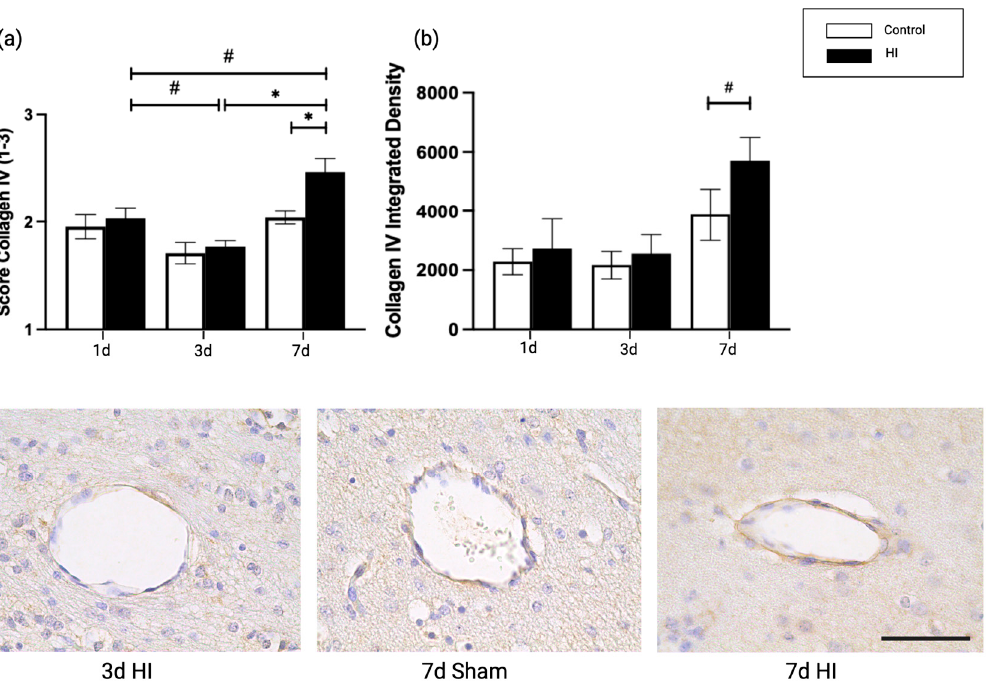
Figure 3. Collagen type IV ( a ) qualitative scoring; ( b ) integrated density measurement on 1, 3 and 7 days after HI; ( c ) representative images of consecutive brain sections of cerebral blood vessels stained with collagen type IV. An average of 40 fields of view per animal were analyzed. Graphs show the average integrated density (mean grey value of stained area × percentage of stained area) of collagen type IV expression in coronal brain sections. Statistical analysis was performed using a Kruskal-Wallis test followed by Dunn’s post hoc test. Bars represent mean ± SEM. Scale bar 50 µm. 400 × magnification * p < 0.05, # p =0.06.